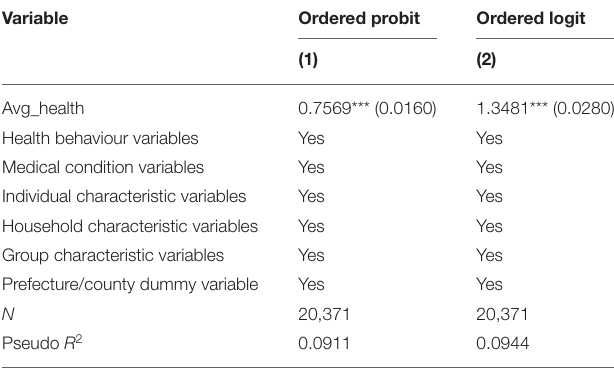
TABLE 5 | Robustness test for the regression based on ordered probit and ordered logit.